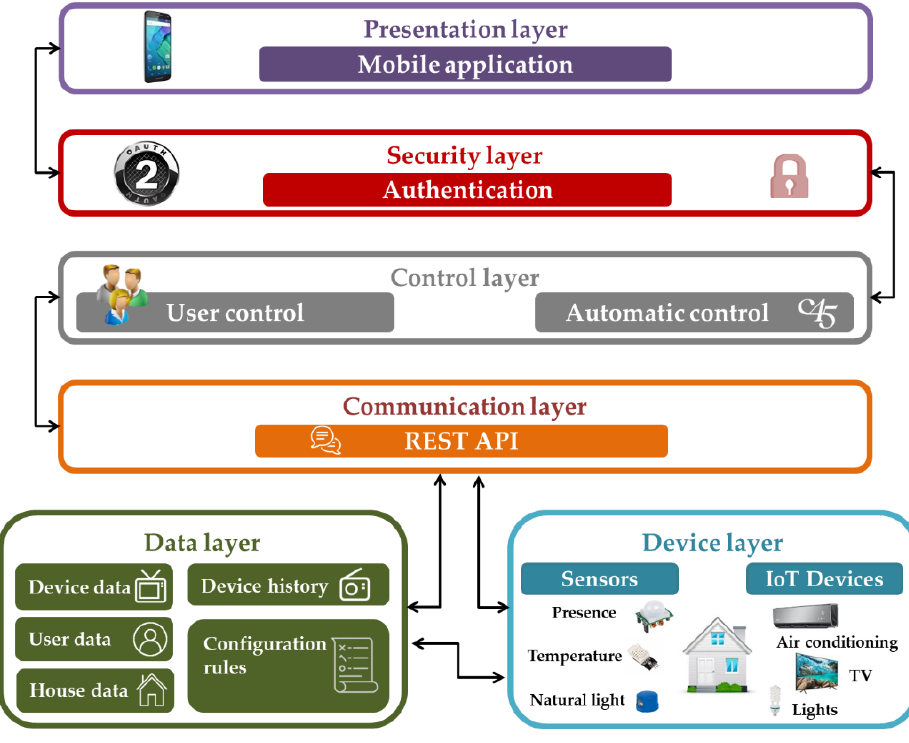
Figure 1. Smart Home Control’s architecture.